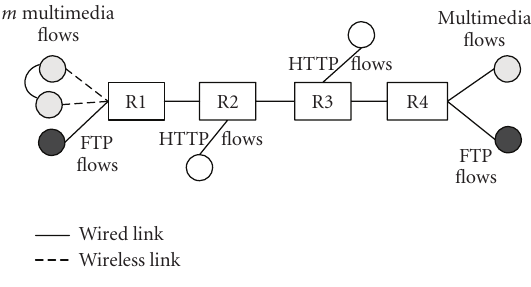
Figure 6: The simulation